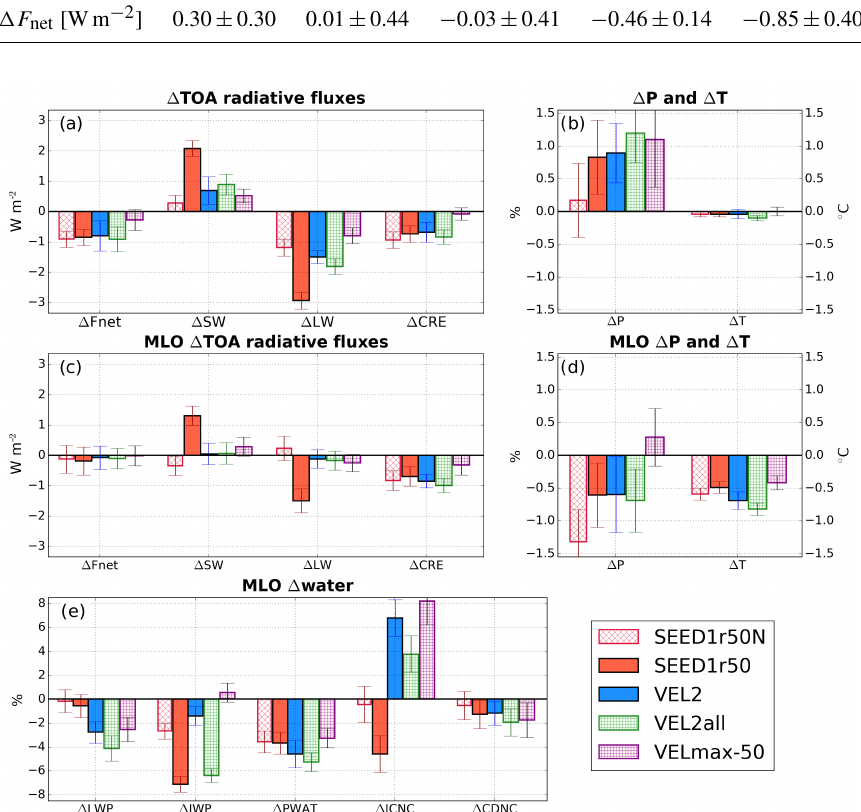
Figure 4. Annually averaged anomalies for top-of-the-atmosphere (TOA) energy fluxes (a, c) , precipitation ( P ), and temperature ( T ) (b, d) and selected quantities of the hydrological cycle (e) : liquid water path (LWP), ice water path (IWP), precipitable water (PWAT), ice crystal number concentration (ICNC), cloud droplet number concentration (CDNC). Panels (a) and (b) show anomalies from fixed SST simulations, while panels (c) , (d) , and (e) show those from mixed layer ocean (MLO) simulations. The error bars represent the ± 2 standard deviation